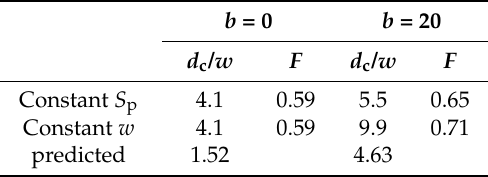
Table 1. Observed and predicted confinement ratio d c / w at the penetration transition between the interstitial volumes for a flexible and semi-flexible chain. The relative standard deviations are <0.1% and ~9%, respectively, for the flexible and semi-flexible chains in the nanopost arrays of both geometry